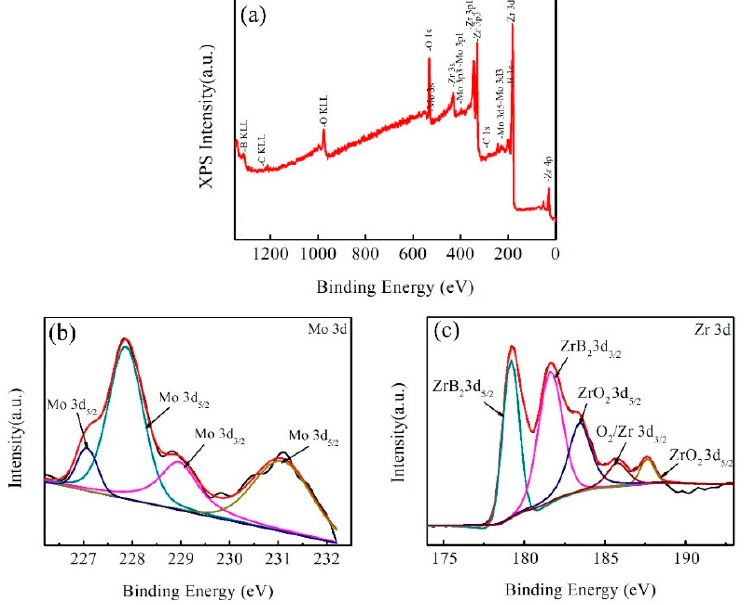
Figure 6. Cross-sectional HRTEM images of the ZrB 2 /Mo multilayer at the modulation ratio of 4:1.